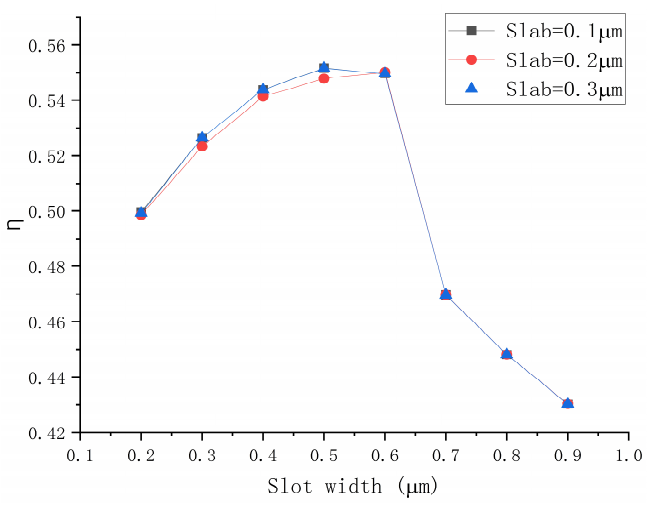
Figure 4. ( a ) Schematic of the coupling structure. ( b ) I out and η corresponding to different slot cross-section sizes.